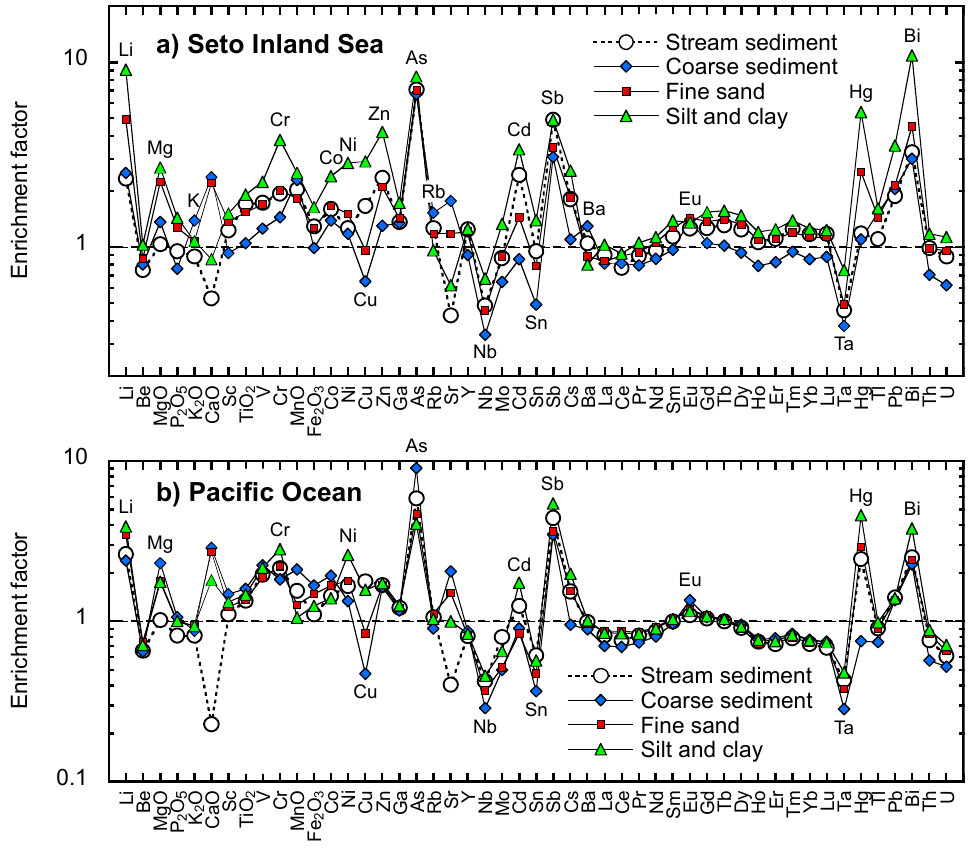
Figure 6. Enrichment factors of 49 elements and oxides in stream and marine sediments of ( a ) Seto Inland Sea and ( b ) Pacific Ocean, compared to the upper continental crust [36] (details in the text).